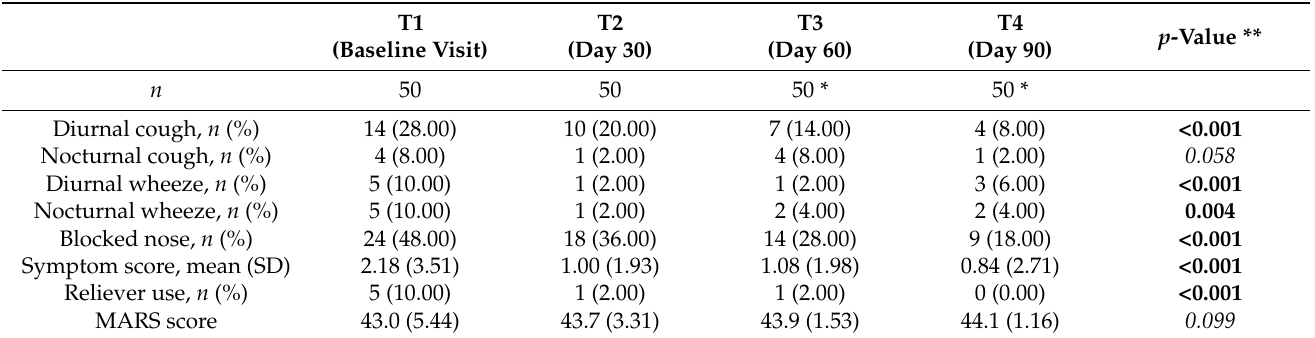
Table 2. Symptoms, reliever use and Medication Adherence Rating Scale (MARS) at each time visit during the study period (March and July 2017).